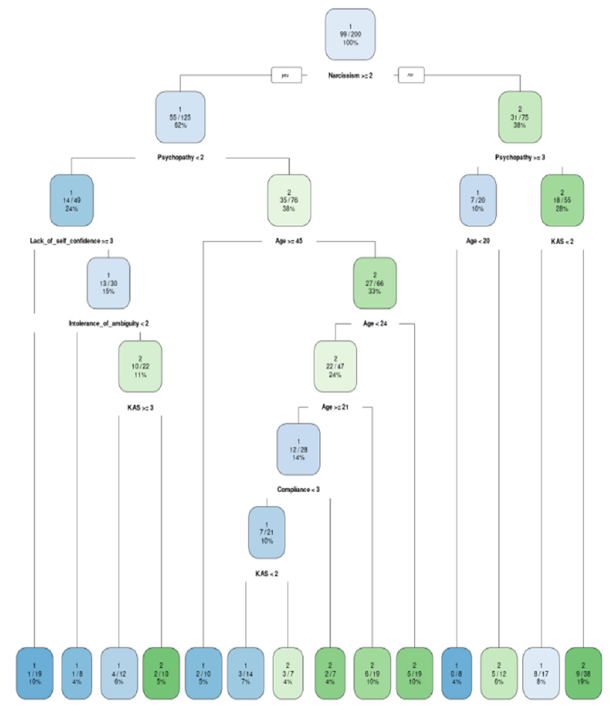
Figure 4. Classification model for a stay in the work: 1—wearing a mask; 2—not wearing a mask.